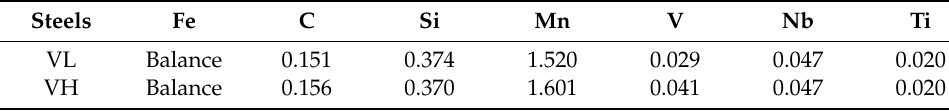
Table 1. The chemical composition of two tested steels.